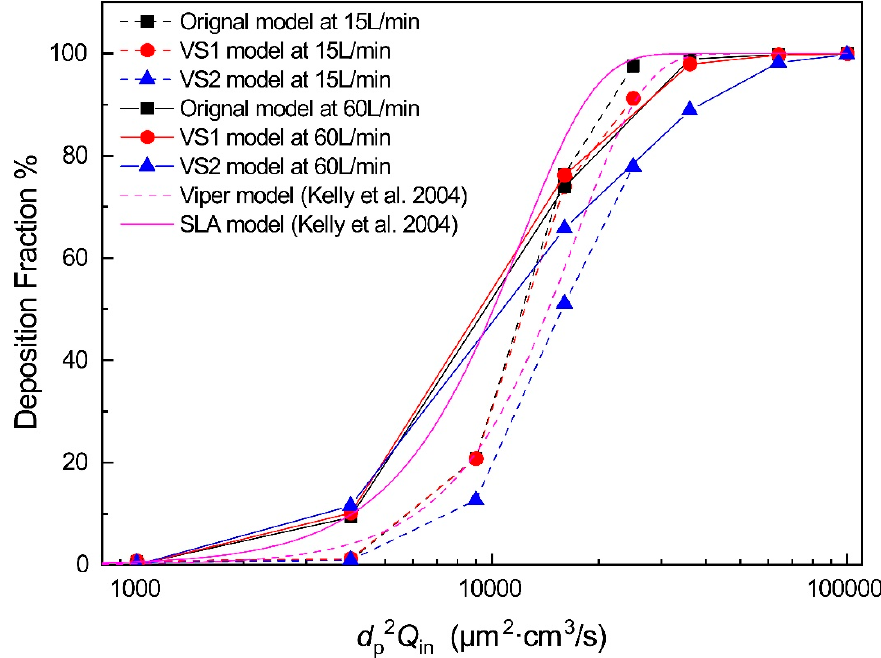
Figure 4. Relationship between deposition fraction of inhalable particles and particle diameter at Q in = 15 L/min [19].